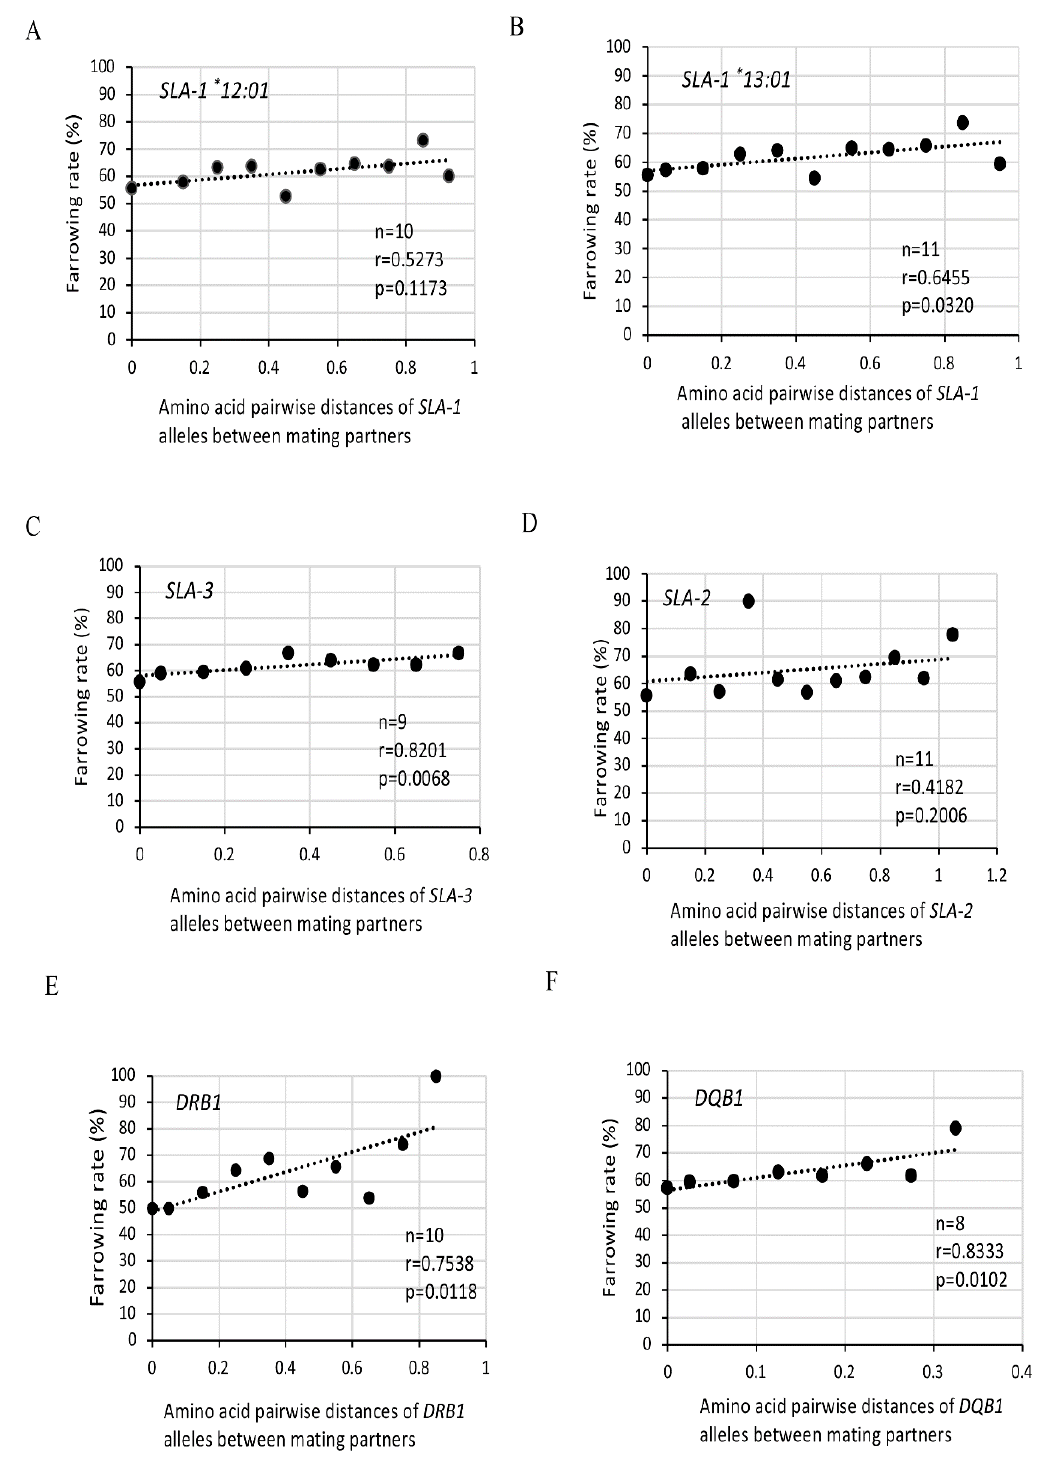
Figure 4. Effects of amino acid pairwise distances of SLA class I and class II alleles between partners on farrowing rates in MMPs. Dots are indicated as farrowing rates (%) in the center value of each group of amino acid pairwise distances of SLA-1 ( A , B ), SLA-3 ( C ), SLA-2 ( D ), DRB1 ( E ), and DQB1 ( F ) alleles between partners as shown in Table 2. Dotted line shows the approximated line. n: number of groups on the sum of pairwise amino acid differences of SLA-1 ( A , B ), SLA-3 ( C ), SLA-2 ( D ), DRB1 ( E ), and DQB1 ( F ) alleles between partners as shown in Table 2. r: correlation coefficient, and p : p value evaluated by Spearman’s rank correlation coefficient.